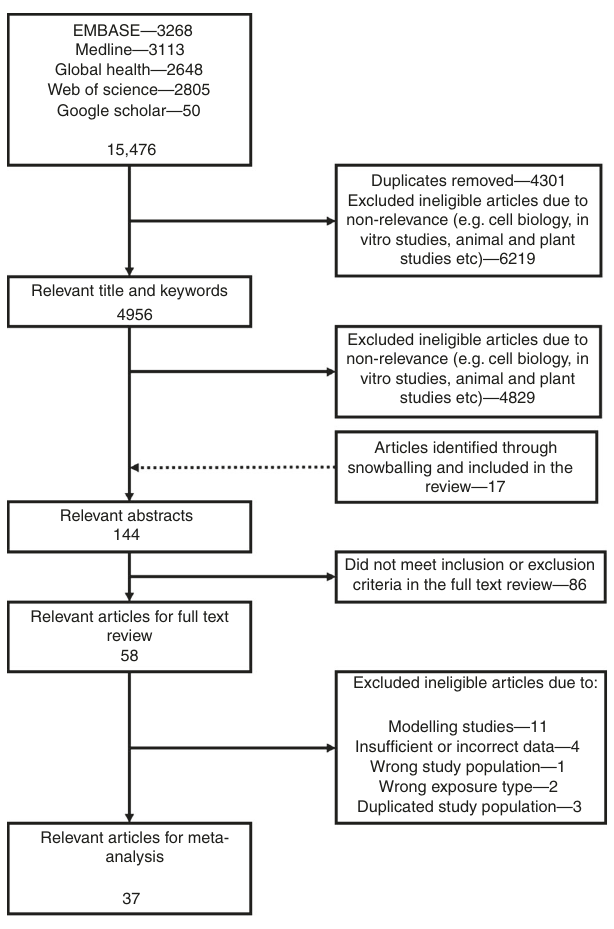
Fig. 1 PRISMA diagram. A fl ow chart of the study selection